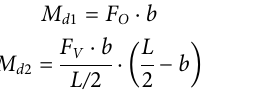
Frontiers in Built Environment |